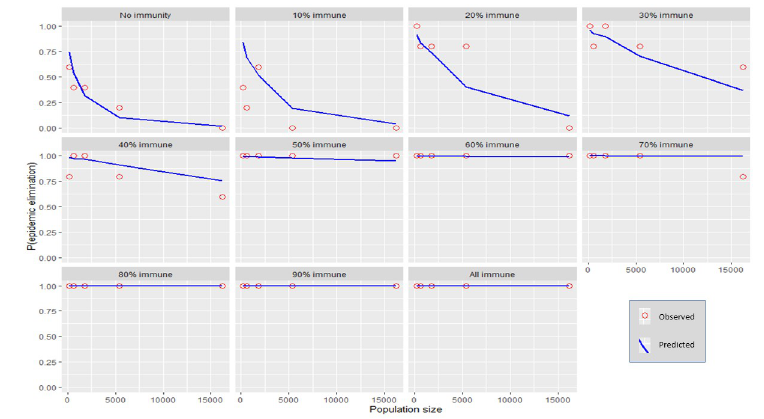
Fig 1. The response of P(elim.) to population size at different herd immunities. The proportion of elimination events from the transmission model (red circles) and the prediction from the regression model (blue